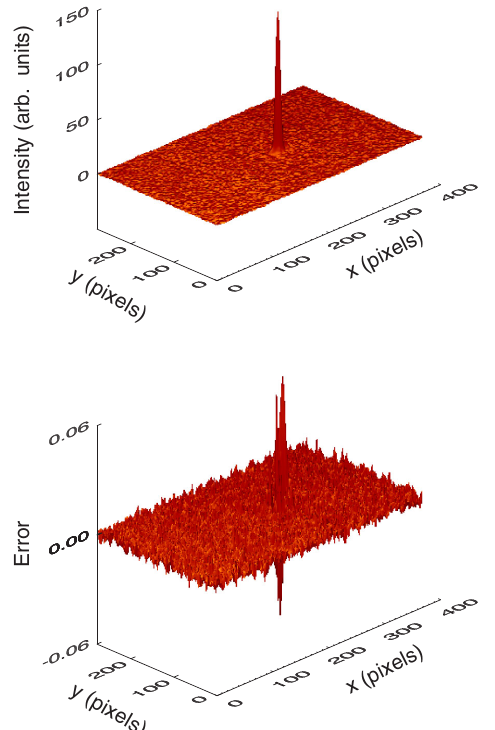
FIG. 16. Measured intensity data taken in 2009 and the residual error. The calibration is 0 . 9 μ m per pixel in the x directions and 1 . 057 μ m per pixel in the y direction. The error has a single ∼ 22% spike outside of the interaction region but the rest is well below 5%.